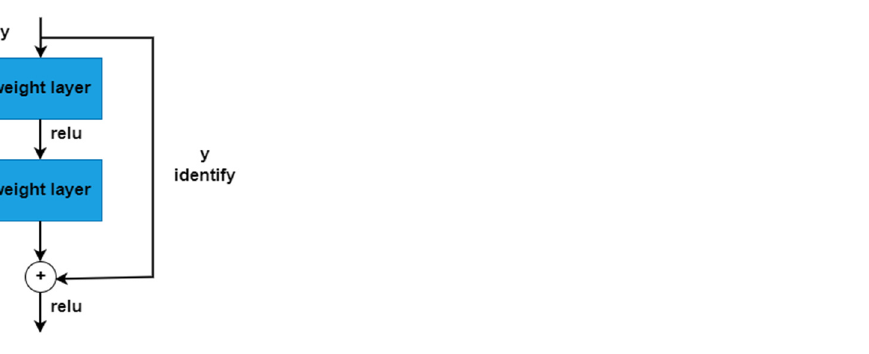
Figure 9. An illustration of how a dense block is used to generate the Mobile-HR model.